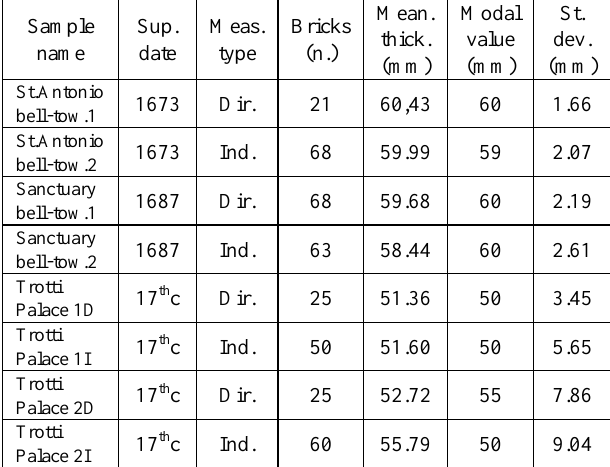
Table 5. Comparison among the data collected by the mensiochronology analyses carried out on the considered sample, with the indication of the supposed dating of the units, direct and indirect measurements, the number of the bricks, the average thickness, the modal and the standard deviation